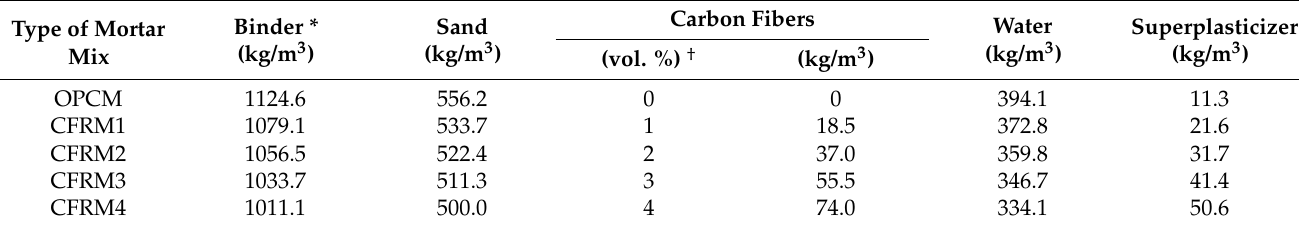
Table 2. Mix proportions of the different mortar